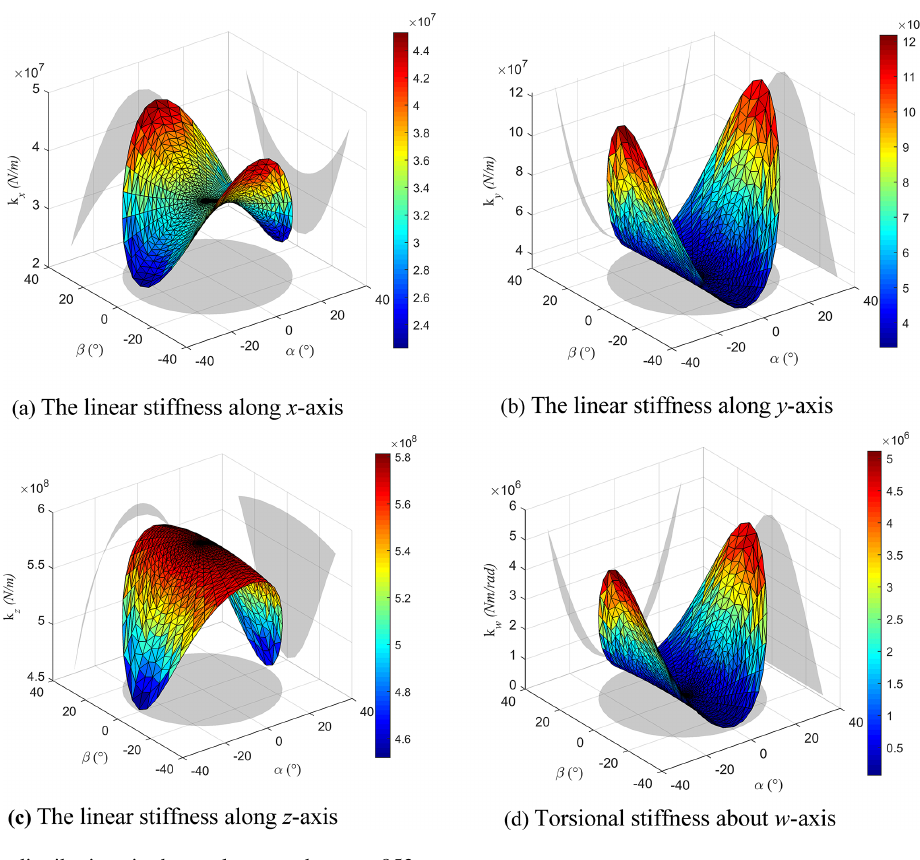
Figure 4. Stiffness distributions in the workspace when z =